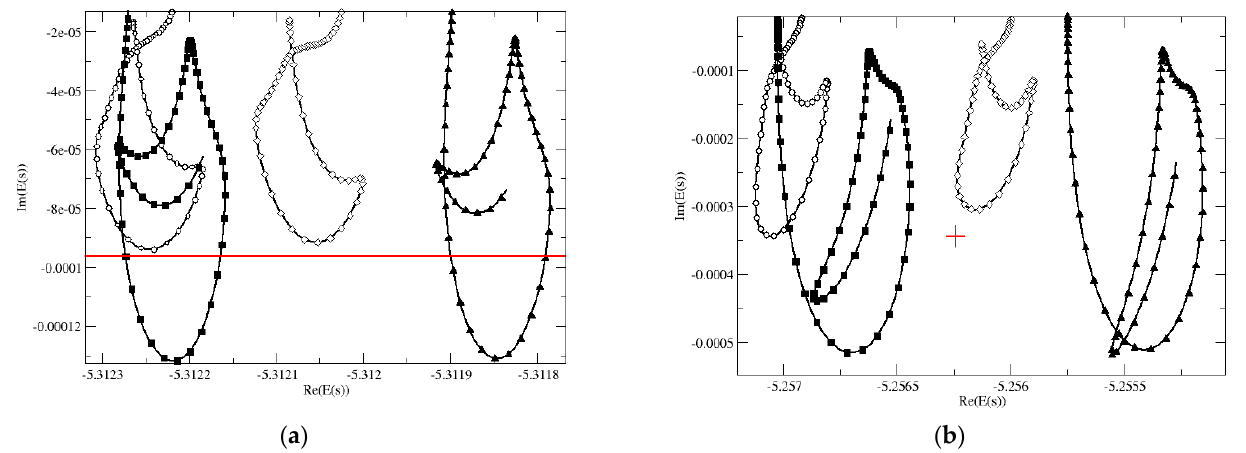
Figure 6. CAP-trajectories in the vicinity of the lowest of the scaling factor λ (26), i.e., ○ —λ = 1.3, □—λ = 1.5, ◊—λ = 1.7. Sign + indicates the position of the resonance [48]. Data are presented in a.u.